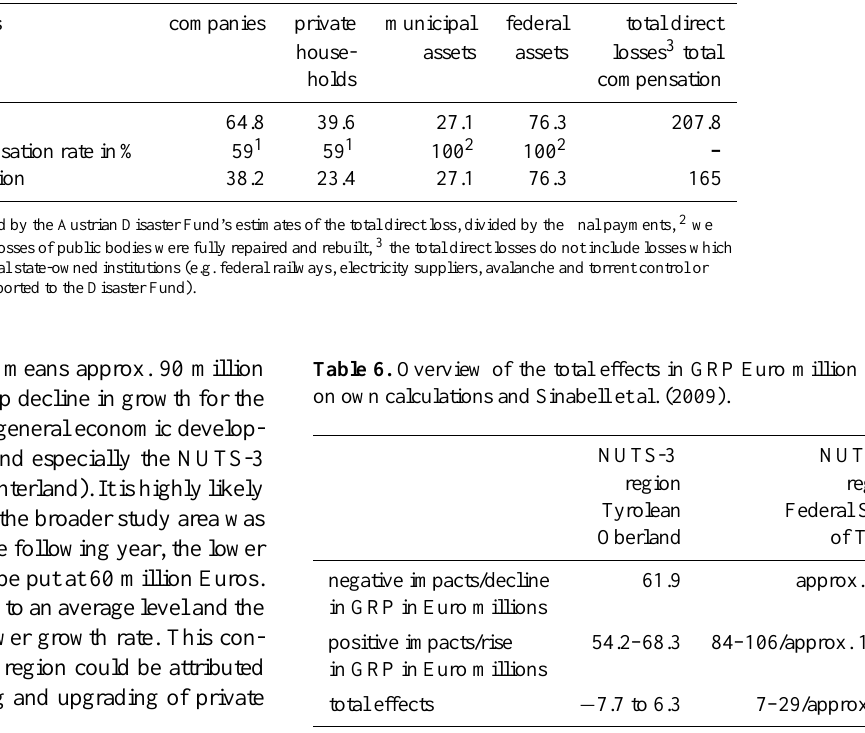
Table 5. Rough calculation of economic stimuli based on damage compensation in million Euros for the Federal State of Tyrol (2006 values); Data sources: Austrian Disaster Fund, Federal State of Tyrol, department for rural areas and agriculture and own calculations.